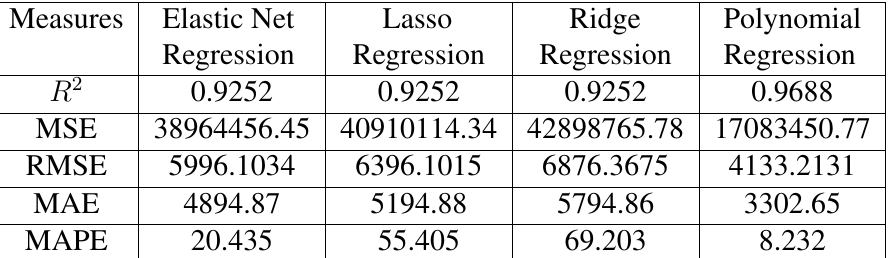
Table 1: Statistical Measures